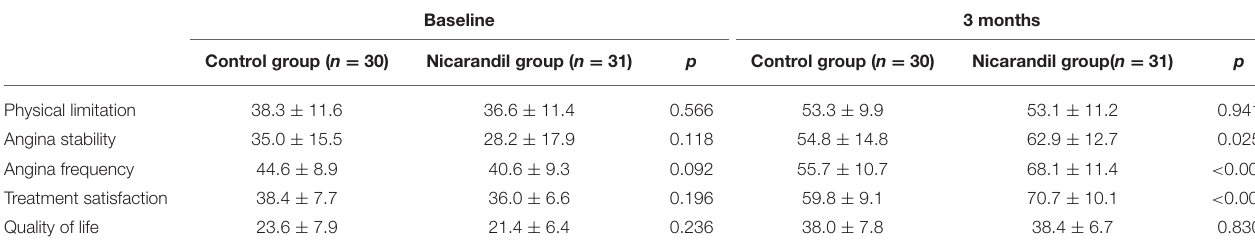
TABLE 5 | Seattle angina questionnaire scores of the nicorandil group and the control